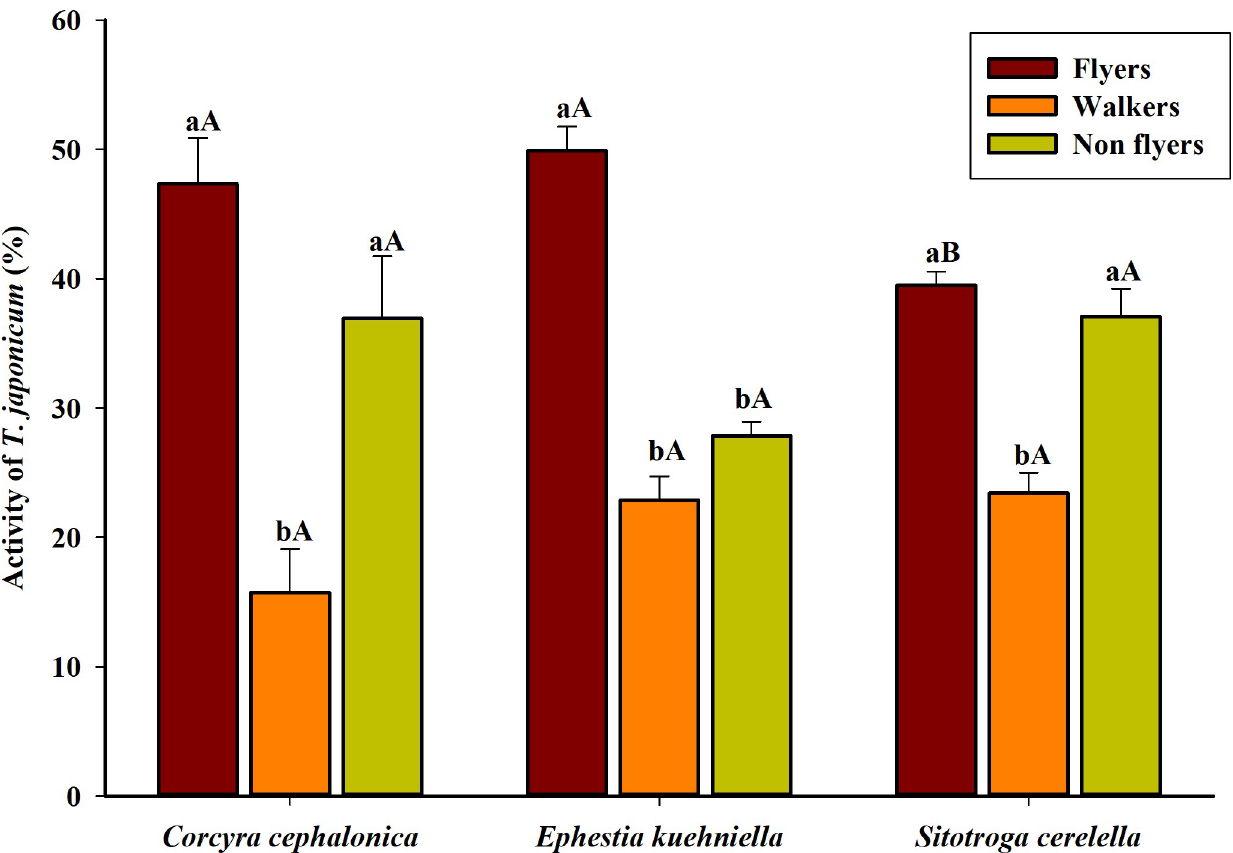
Fig 1. Flight propensity of Trichogramma japonicum emerged from the eggs of different factitious hosts. Three flight activities were measured, flyers, walkers and non-flyers. The values are presented as the mean ± standard errors. Treatments were compared using one-way ANOVA (Tukey’s HSD test, P < 0.01). The same letter above error bars (capital letters across host species, lowercase letters across flight activities) did not differ significantly ( P � 0.01).